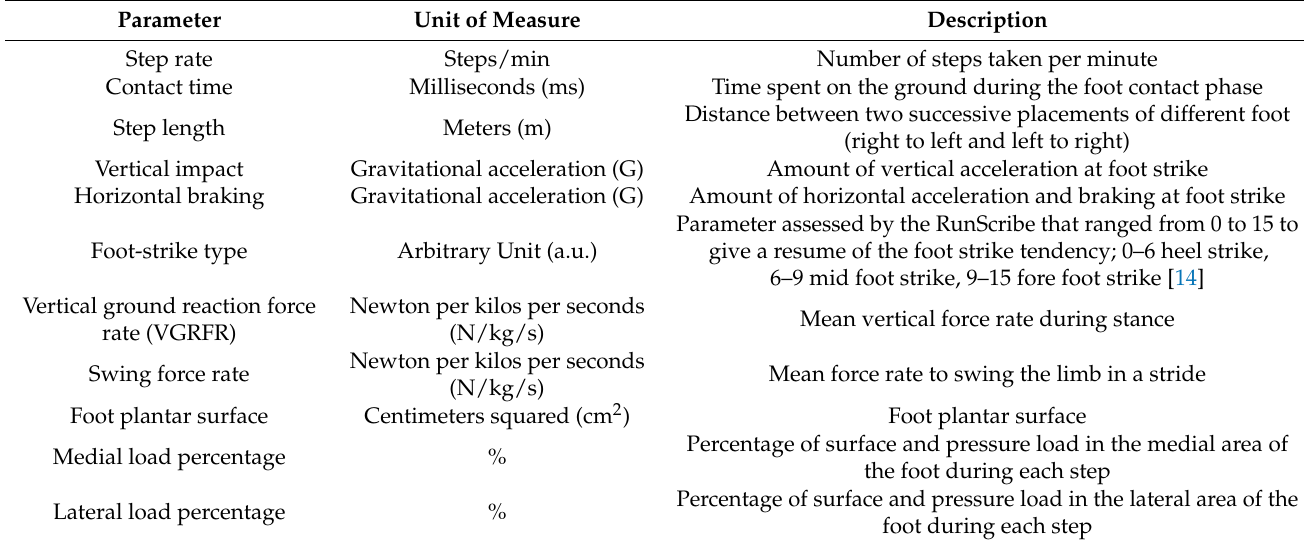
Table 1. Glossary of the kinematic, kinetic, and plantar pressure variables used in this study.